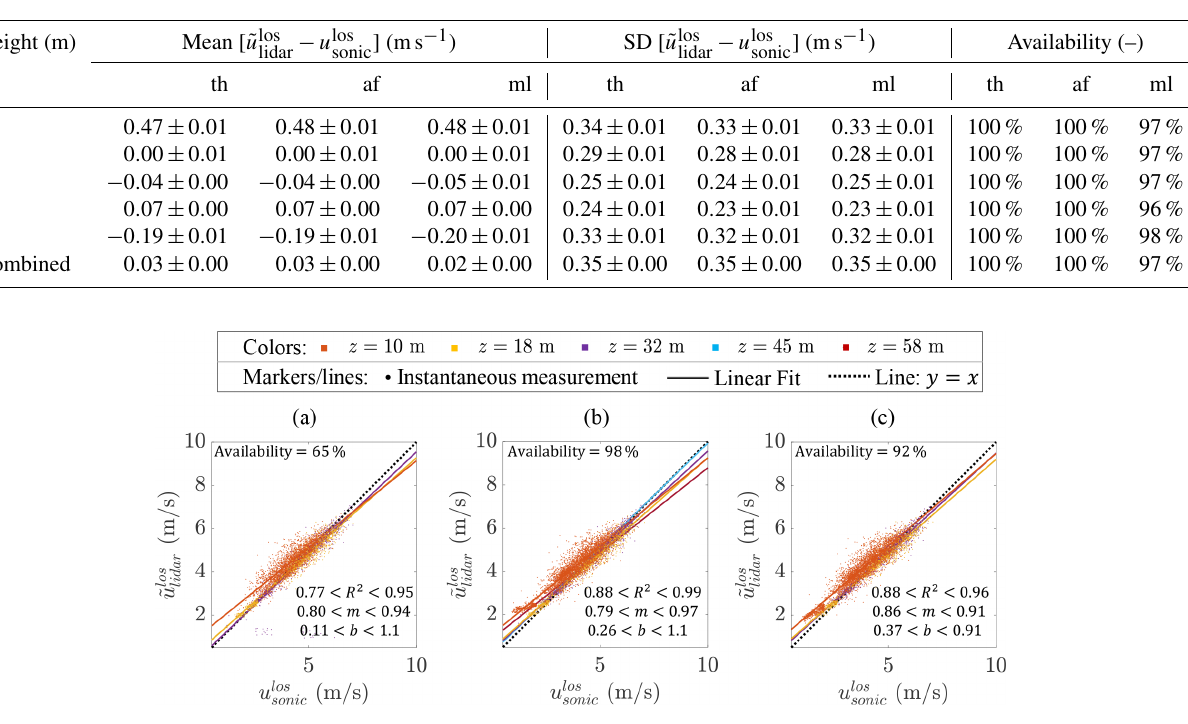
Figure 12. Instantaneous lidar line-of-sight spectral median velocity estimates, ˜ u los mates, u los , for inflow cases with solid interference from the (a) thresholding, (b) advanced filtering, and (c) machine learning techniques. sonic The variations shown for the coefficient of determination value, R 2 , the linear fit slope, m , and the linear fit offset, b , correspond to the ranges observed across the fits at all five comparison